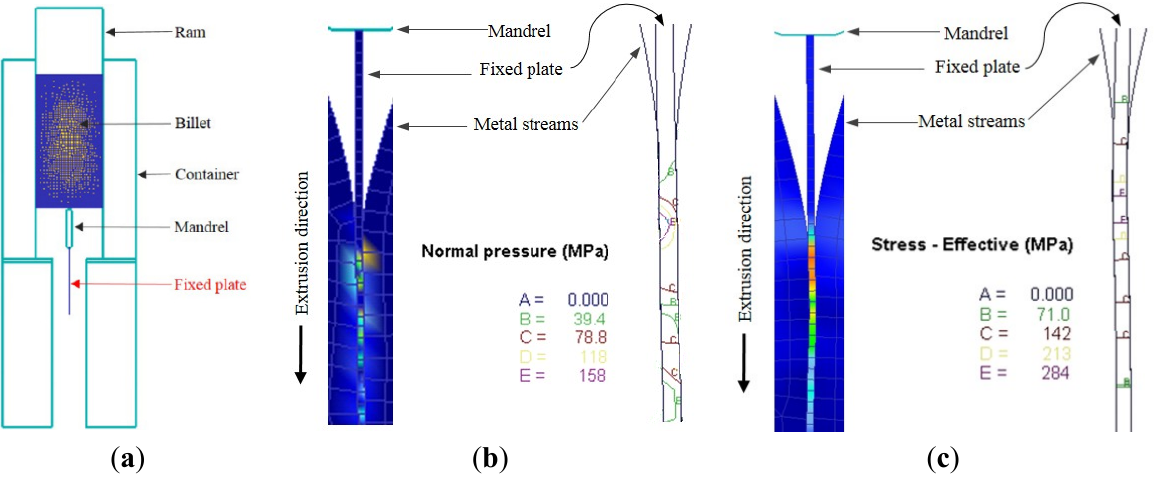
Figure 4. ( a ) The used fixed plate model [12,13]; ( b ) Normal pressure distributions on the fixed plate; ( c ) Effective stress distributions on the fixed plate (at a ram speed of 10 mm/s, a billet temperature of 470 °C, and for a constant simulation step number of 450).